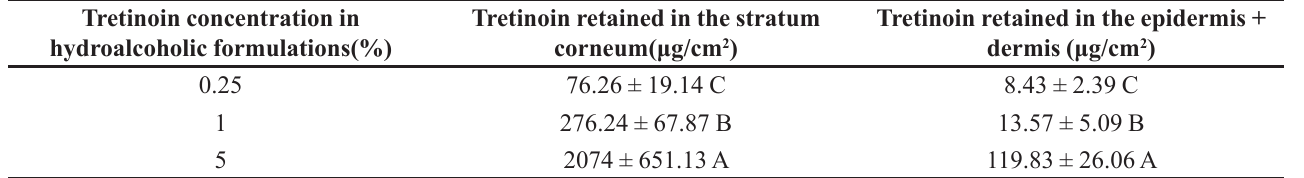
TABLE II - Tretinoin average concentrations retained in skin layers ( μ g/cm 2 ) for the three hydroalcoholic formulations Tretinoin concentration in hydroalcoholic formulations(%)